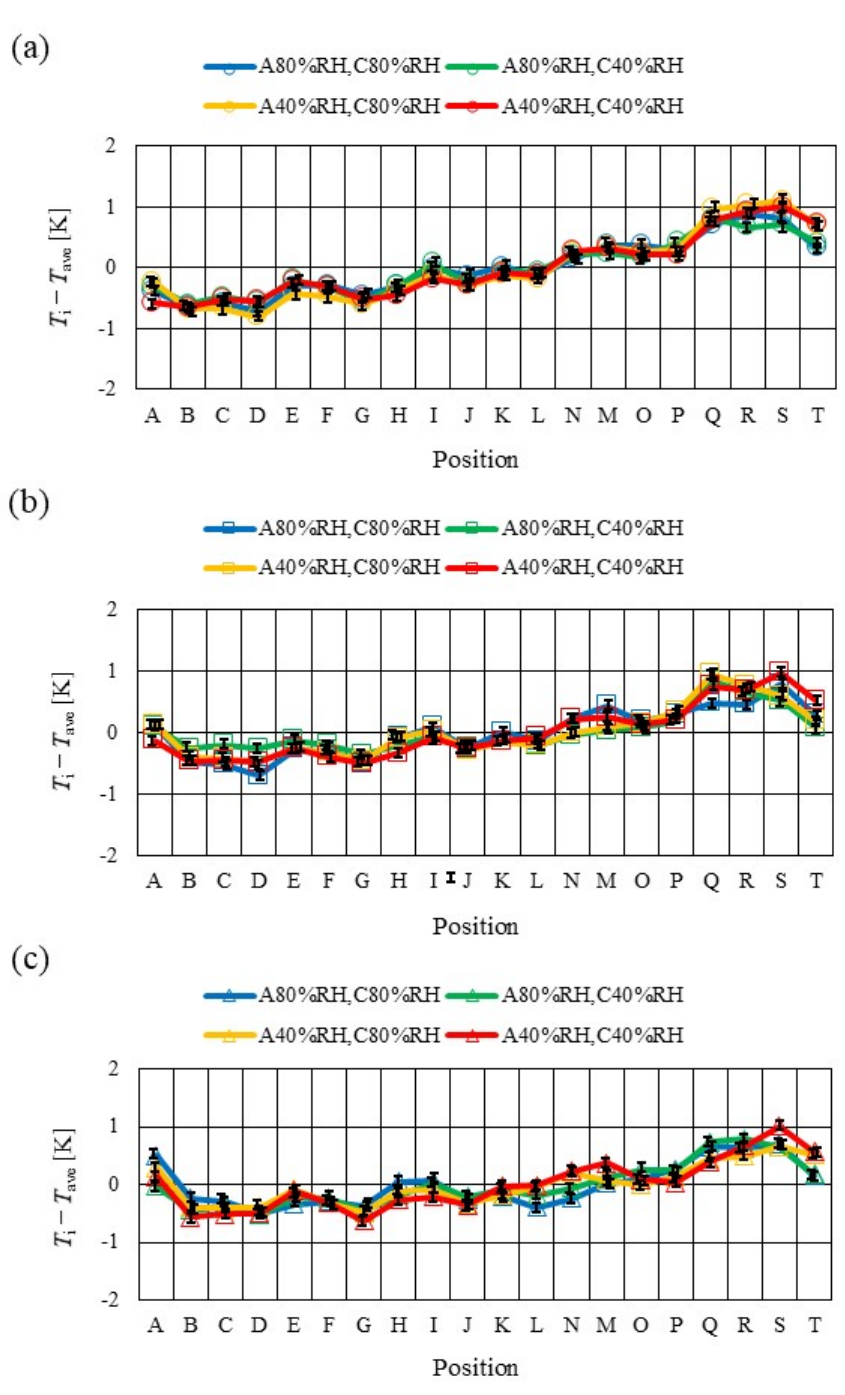
Figure 17. Comparison of in-plane temperature distributions at the cathode side among different RHs in the case of the separator thickness of 1.5 mm: ( a ) T init = 353 K; ( b ) T init = 363 K; ( c ) T init = 373 K. A80%RH&C80%RH, A80%RH&C40%RH, A40%RH&C80%RH and A40%RH&C40%RH were investigated. The temperature increases from the inlet to the outlet gradually.